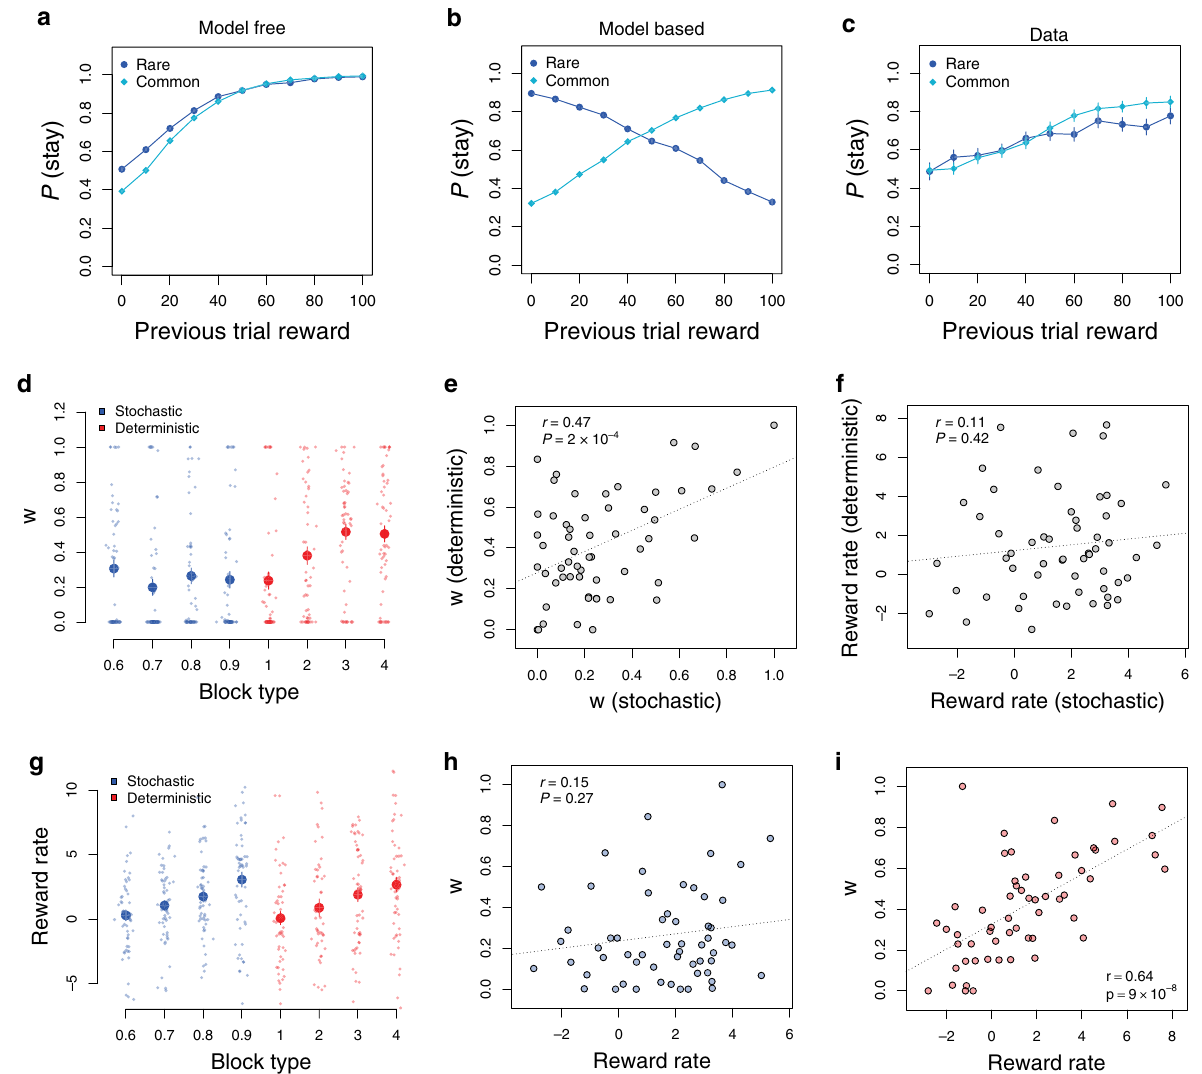
Fig. 2 Simulations and behavioral results. a Example simulation of a purely model-free agent ( w = 0) in the stochastic transition task: the probability to stay with the same fi rst-stage choice increases with the previous trial ’ s reward, but does not depend on the previous transition (common (dark blue circles) or rare (light blue diamonds)). b Example simulation of a purely model-based agent ( w = 1) in the stochastic transition task: the probability to stay with the same fi rst-stage choice decreases with the previous trial ’ s reward if the previous transition was rare. c Probability to stay with the same fi rst-stage option in the stochastic transition task: subjects display very little model-based behavior ( N = 57 individual subjects). d Model-based weight w by condition (block type): 0.6 – 0.9 correspond to the common transition probability (stochastic condition, in blue), and 1 – 4 denote the pattern type (deterministic condition, in red). e Correlation in model-based weight w between stochastic and deterministic conditions. The weights are calculated as the averages of block-wise estimates. f Correlation in reward rate between stochastic and deterministic conditions. g Reward rate by conditions (block type) and pattern dif fi culty ( N = 57 individual subjects). h – i Correlation between the model-based w and reward rate in the stochastic ( h ) and deterministic ( i ) conditions. All correlation plots show Pearson correlations, each individual point is one subject, and dotted lines indicate linear regression fi ts. In bar plots: dots denote individual subjects, error bars denote s.e.m. at the subject level. Source data are provided as a Source Data fi (cid:3) 0 : 12 (s.e. 0.2), t(55) = − 0.6, p = 0.54). Reward rate did increase with the common transition probability (mixed effects regression, β ¼ 8 : 9 (s.e. 2.2), t(64) = 4.6, p = 8 (cid:1) 10 (cid:3) 6 , Fig. 2g) but this would also occur for a pure model-free learner (as con fi rmed by a simple simulation of a model-free subject).